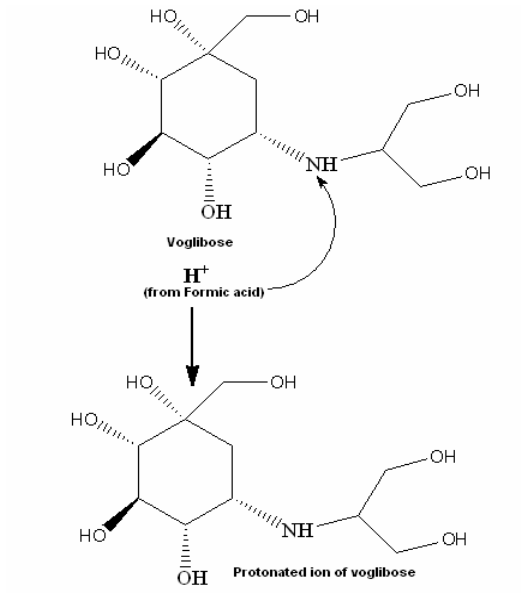
Figure 6. Role played by formic acid in protonating the molecule